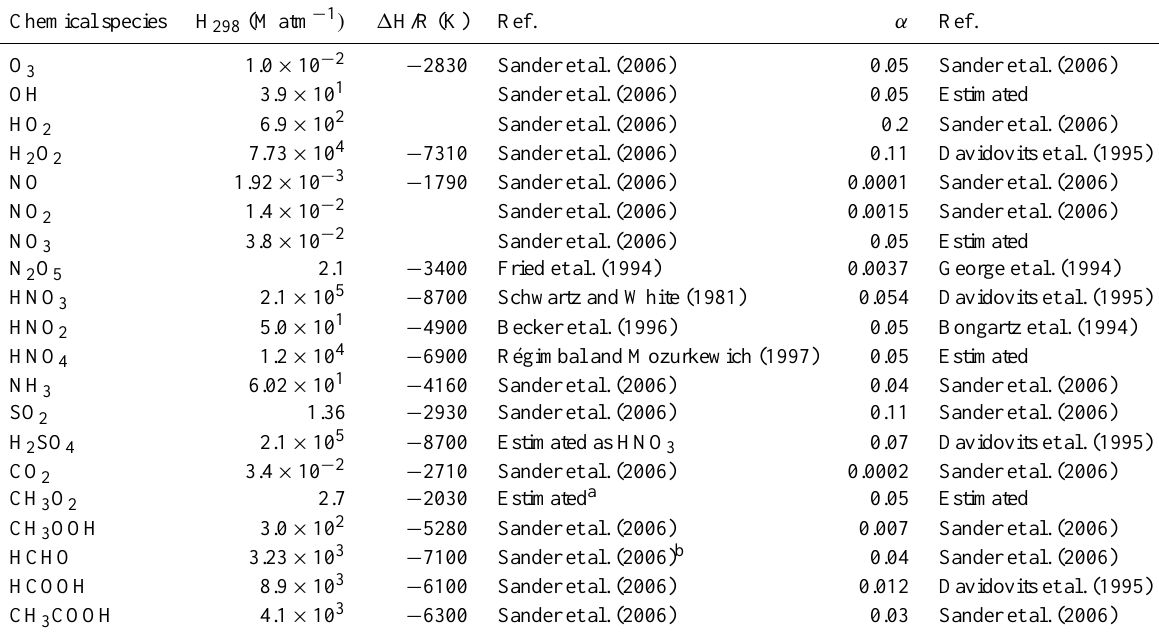
Table 1. Values of Henry’s law constants at 298 K (H 298 ) and associated temperature dependencies ( 1 H/R) and values of mass accommo- dation coefficients ( α)